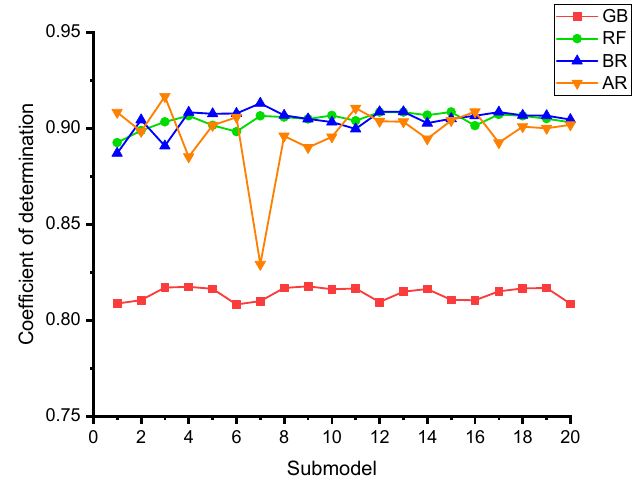
Figure 17. Dispersal of R 2 for the employed ML models.